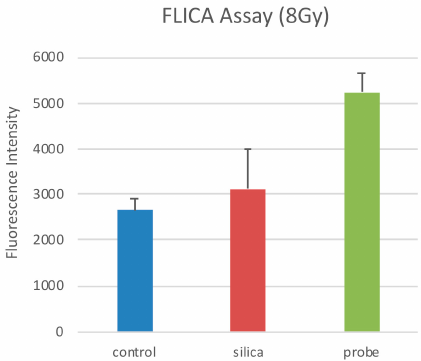
Figure 11. The highest fluorescence intensity resulted from the combination of PCSN probes and 8- Gy irradiation. There was a significant difference between “probe” and the other samples, showing that combination therapy caused the greatest extent of apoptotic cell death. * p < 0.1. Control: SK-BR3 cells, silica: cells in medium containing 1200 ppm PCSNs, probe: cells in medium containing 1200 ppm PCSN probes.